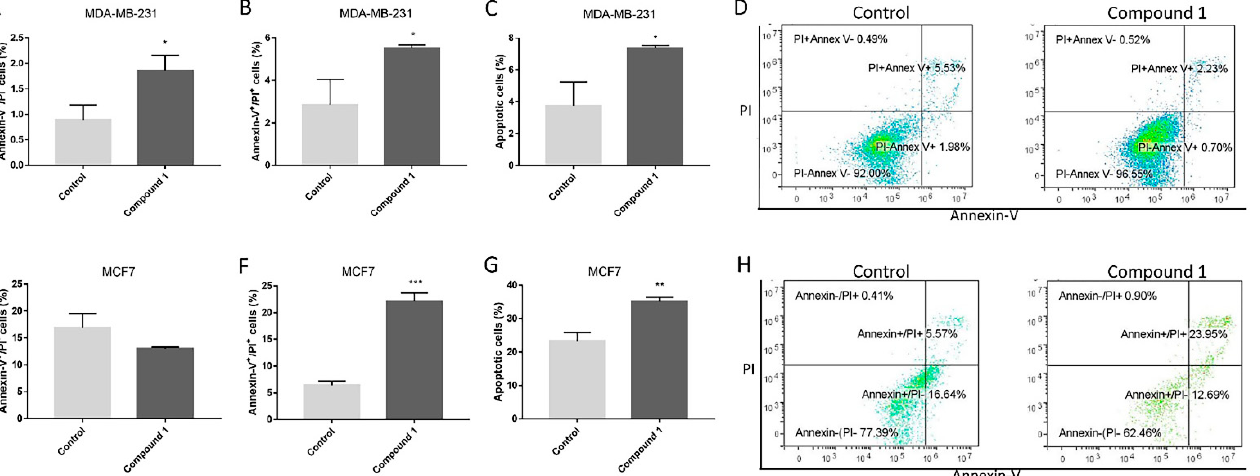
Figure 1. Cell viability after compound 1 treatment. Notes: Cells were treated with a different con- centration of compound 1 for 24, 48 and 72 h in the MDA-MB-231 ( A ) and in the MCF-7 cell line ( B ), and cell metabolism was evaluated by the 3-(4,5-dimethylthiazolyl-2)-2,5-diphenyltetrazolium bro- mide (MTT) assay. Data are expressed as a mean from the experiment performed in triplicate ± SD. Columns, mean of viable cells; bars, SD (standard deviation); a, p < 0.05; b, p < 0.01; c, p < 0.001. SD, standard deviation.